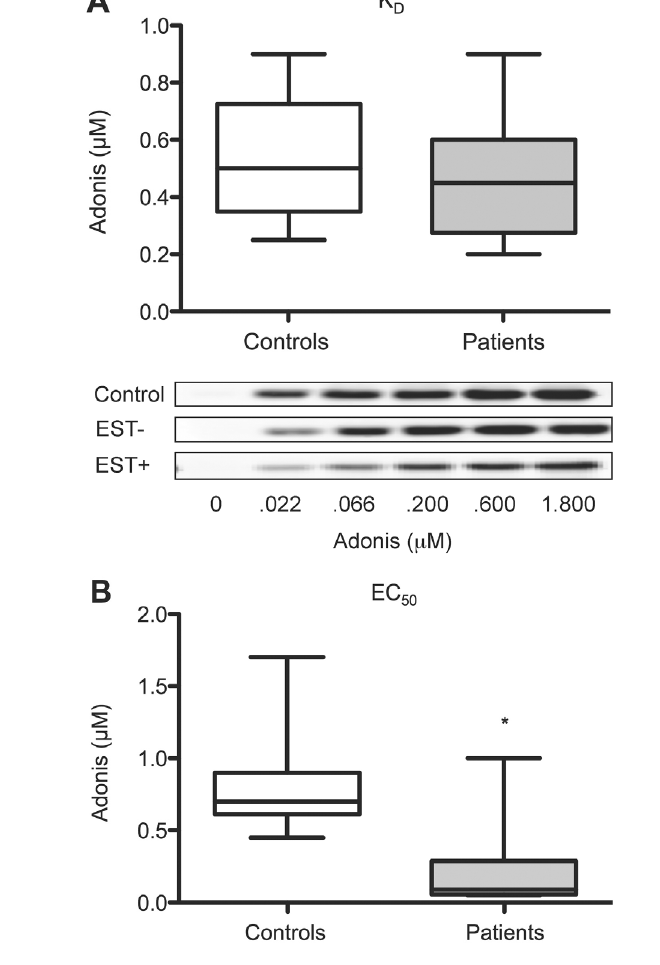
receptor characterization. (A) K figure 2. Adenosine A 2A from dose-response curves obtained using increasing concentrations of Adonis, an anti-A R monoclonal antibody with agonist properties (see methods). Comparison of 2A K values (controls versus patients: P = 0.3; Western blot analysis of the light chain [25 kDa] D of Adonis in a representative sample of each group of interest are shown in the insert). (B) Comparison of EC values (*: P < 50